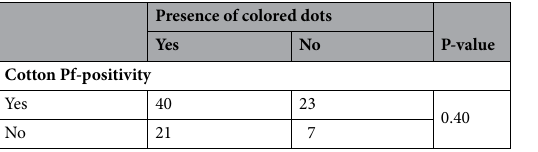
Table 2. Association between sugar feeding (presence of colored dots) and production of Pf-positive cotton samples (cotton Pf-positivity). Cotton Pf-positivity: yes (positive cotton) and no (negative cotton). Presence of colored dots: yes (presence of colored dots) and no (absence of colored dots). Pf indicate Plasmodium falciparum . P = 0.40, no association between sugar feeding and cotton Pf-positivity.